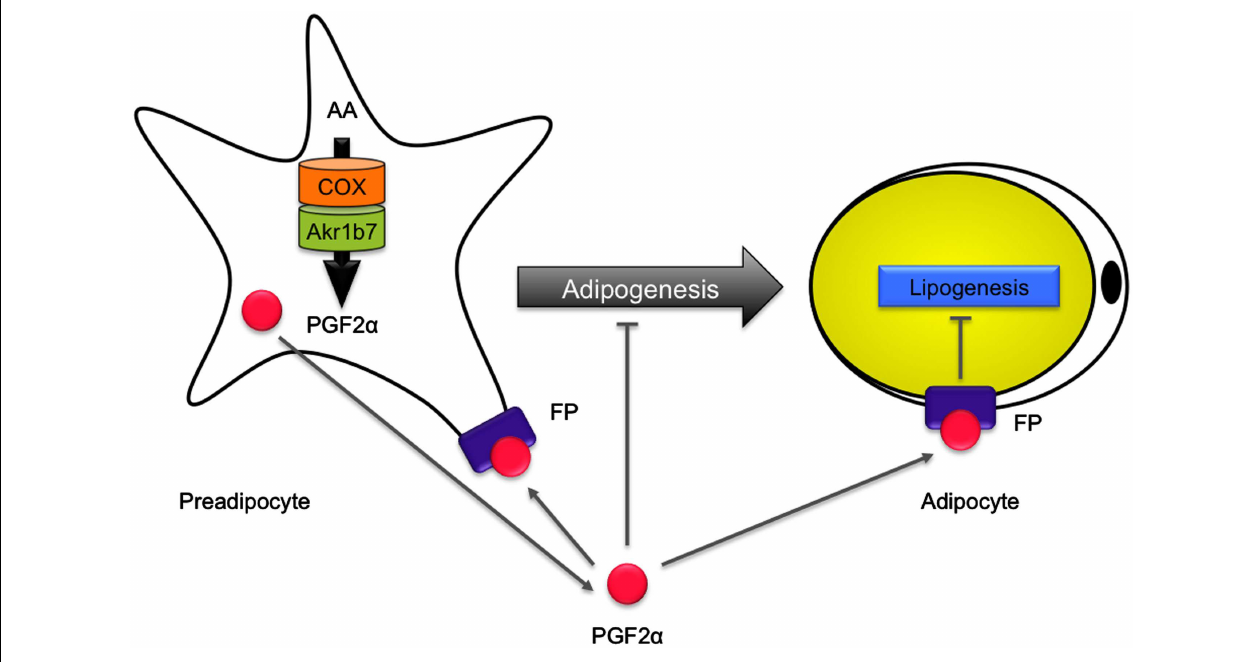
preadipocytes that inhibits their differentiation into adipocytes. In addition, PGF 2 α inhibits lipogenesis in mature adipocytes. Accordingly, altered production of PGF 2 α in Akr1b7 − / − mice leads to an expansion of adipose tissue due to both hyperplasia and hypertrophy of